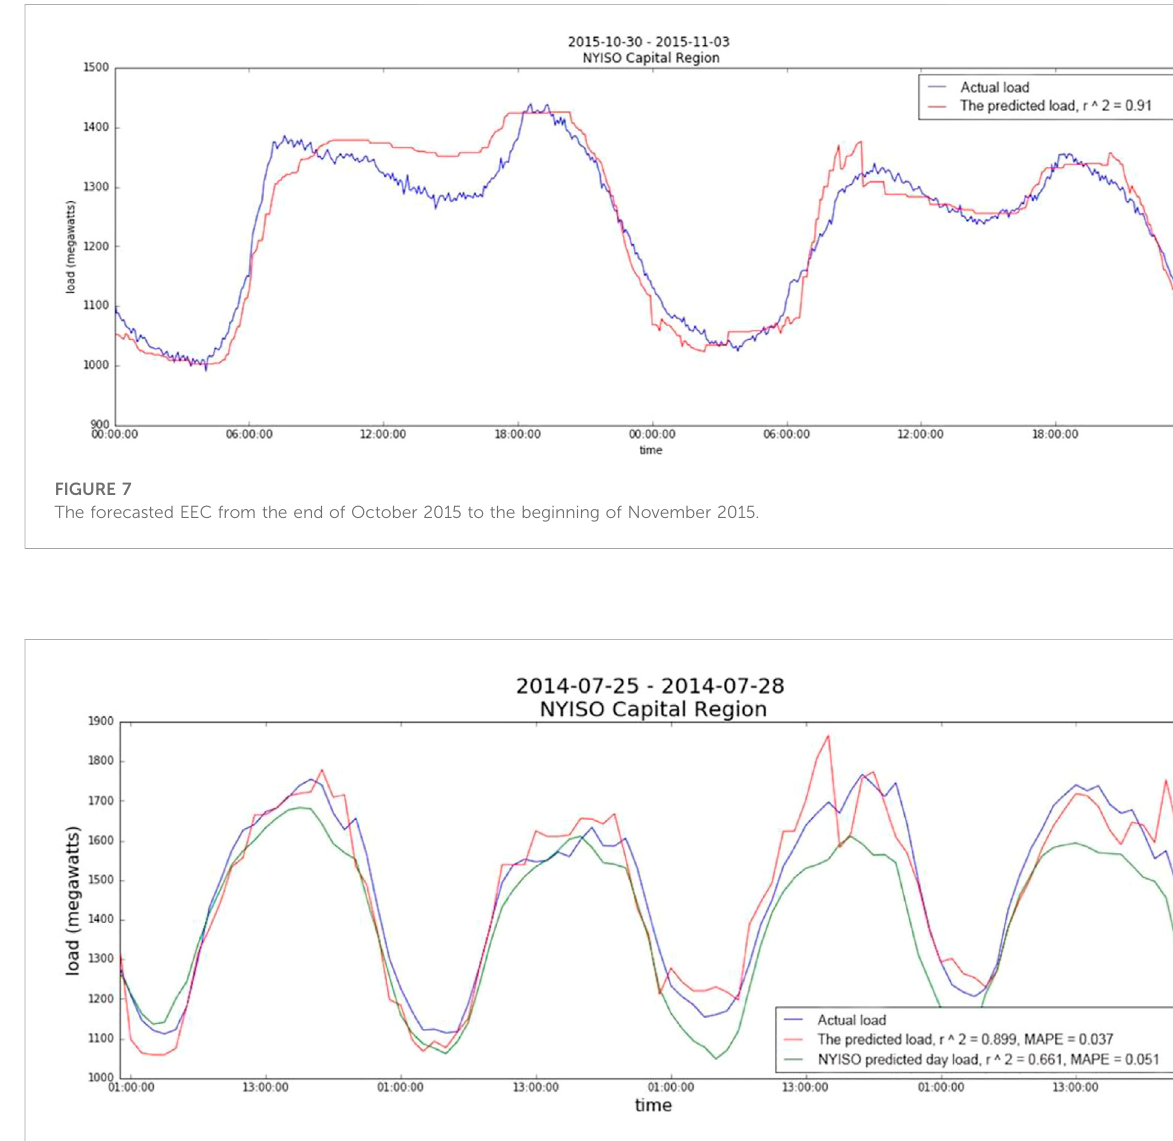
FIGURE 8 The forecasted EEC at the end of July